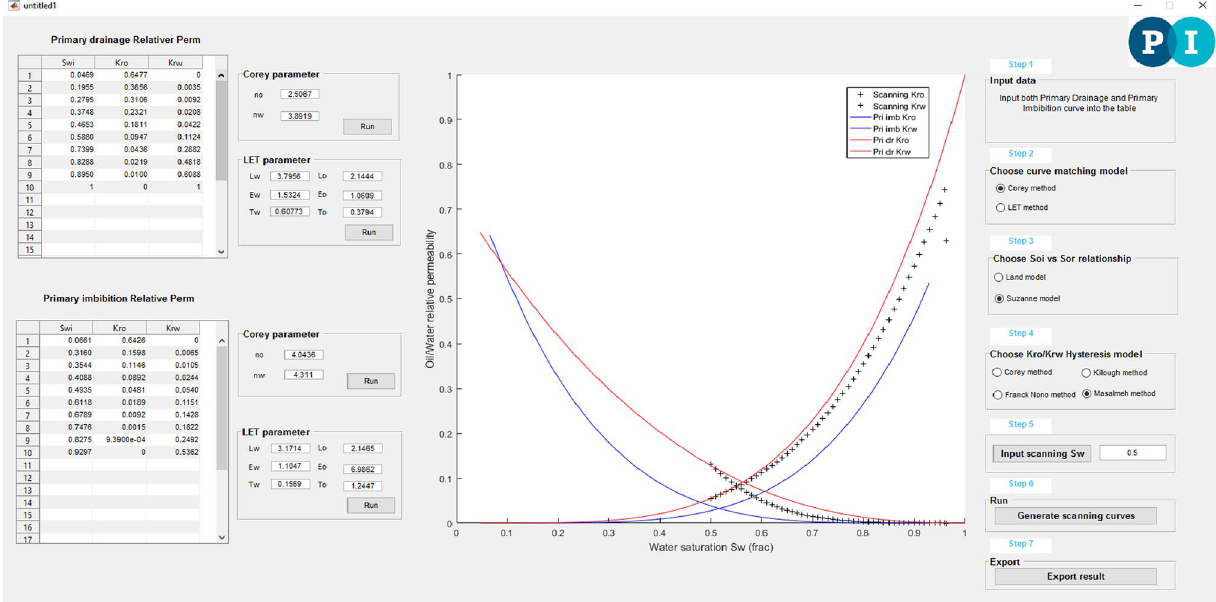
Fig. 12 Relative permeability scanning curves generation